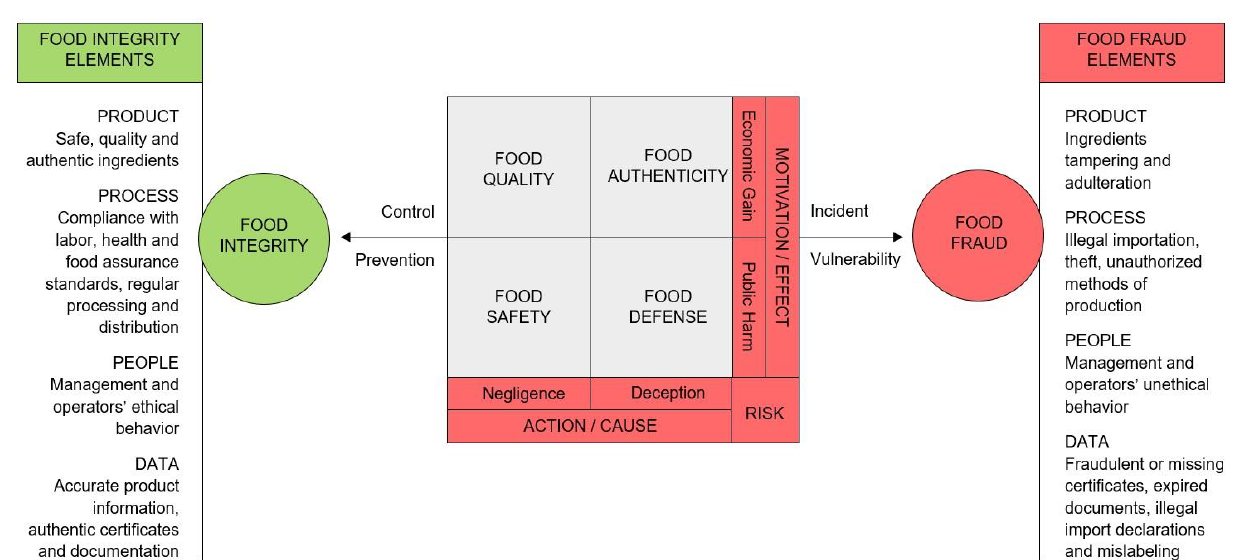
Figure 1. Schematic representation of the nature and interconnection of food integrity and food fraud elements. As two opposed faces of the same coin, food integrity and food fraud both concern the entirety of the food supply chain aspects involved in the food production, including product, process, people, and data, as well as the activities employed in the monitoring of food, such as quality, safety, authenticity, and defense. In the case of food fraud, such elements and activities are managed fraudulently and improperly causing incidents and vulnerability along the food supply chain. Oppositely, food integrity represents the ethical manner and preventive approach through which food companies control the overall food production (adapted from Spink and Moyer (2011) [24] and Manning (2016)